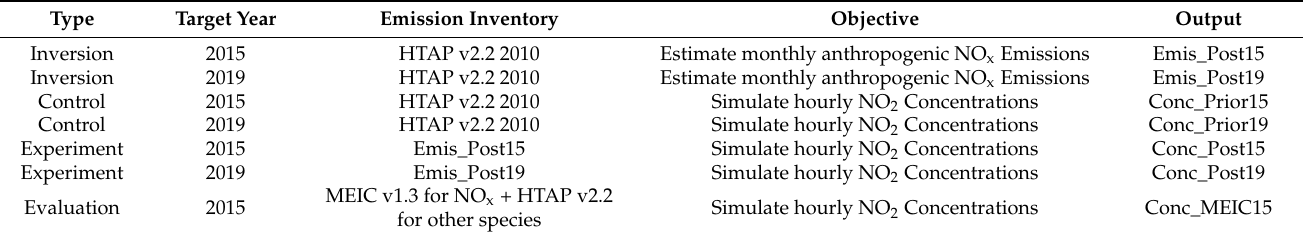
Table 1. Summary of the inversions and simulations performed in this study. The output column gives the short names, which will be used in the